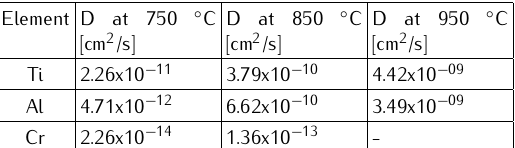
Table 3. The average intrinsic diffusion coefficients of Al, Ti and Cr at 750 ◦ C - 950 ◦ C calculated by the IM